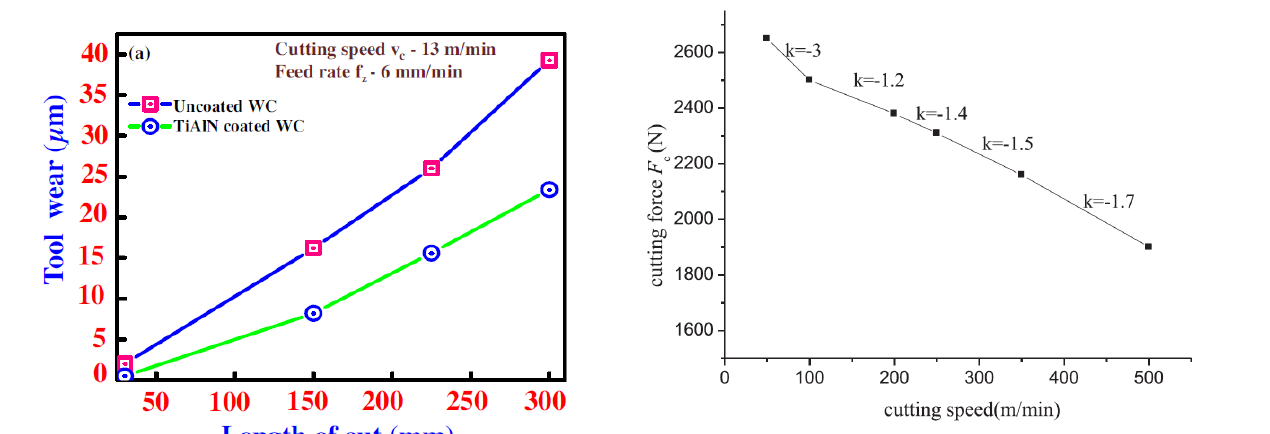
Figure 9: Effect of cutting speed on cutting force [35] that cutting forces decreased when speed was increased from 40 to 100 m/min in machining of Inconel 718. Ezila- rasan et al. [10] concluded that a reduction in tangential turning of Nimonic C-263 super alloy. In accordance